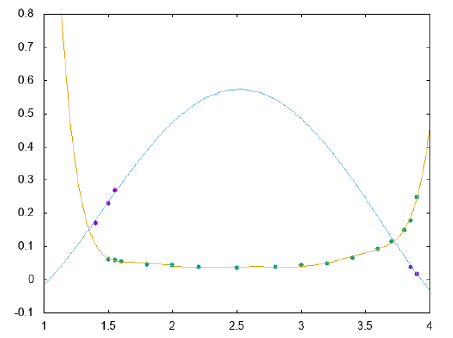
Figure 11 . The two boundary energies f 1 f 2 plotted vs. r , for k = 5 in the j = 0 sector. s The critical values of r c are the points of inter- section of the two curves.